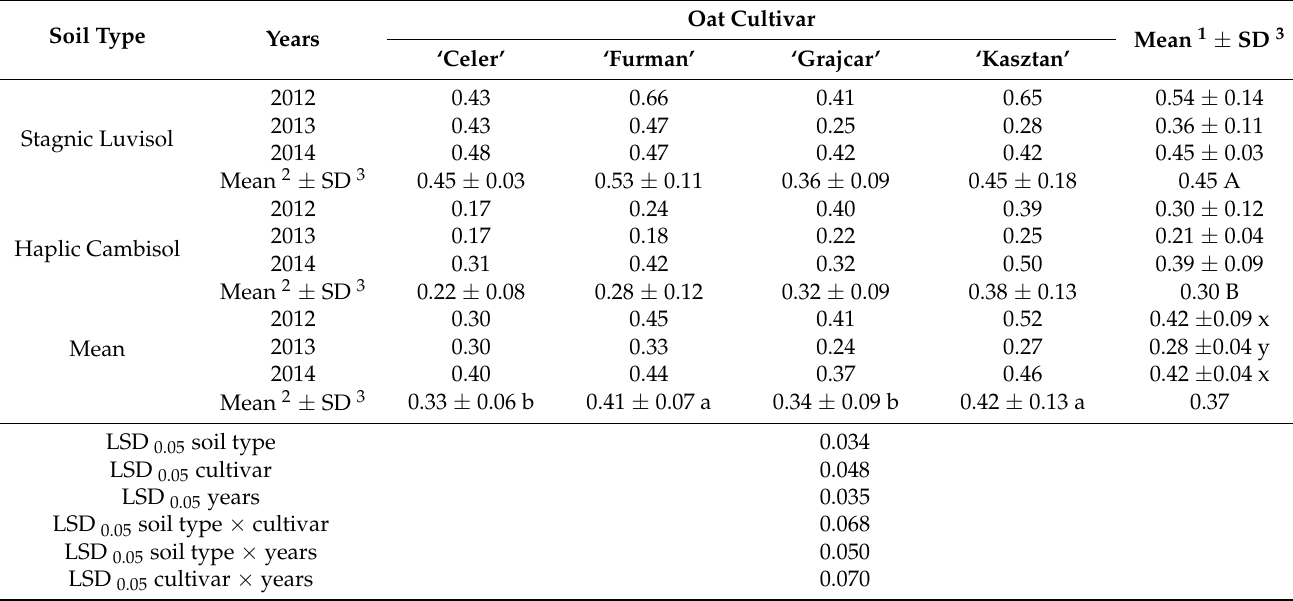
Table 13. Mass grains (g) per oat panicle in the oat–vetch mixture depending on the soil type (factor I), oat cultivar (factor II), and study years (factor III).